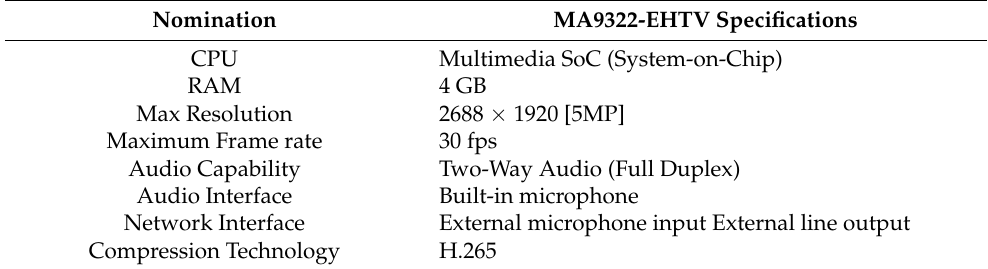
Table 4. VIVOTEK camera